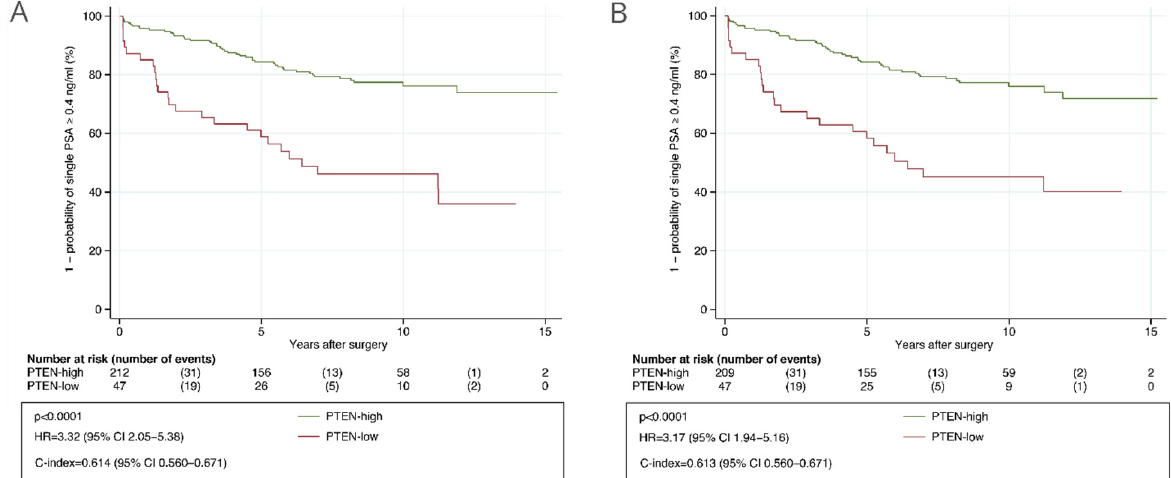
Figure 3. Kaplan–Meier analysis of time to biochemical recurrence after radical prostatectomy stratified by PTEN status in the validation cohort. ( A ) Determined with automatic PTEN scoring. ( B ) Determined with manual PTEN scoring after consensus. Abbreviations: CI = confidence interval; HR = hazard ratio; PTEN = phosphatase and tensin homo- log.